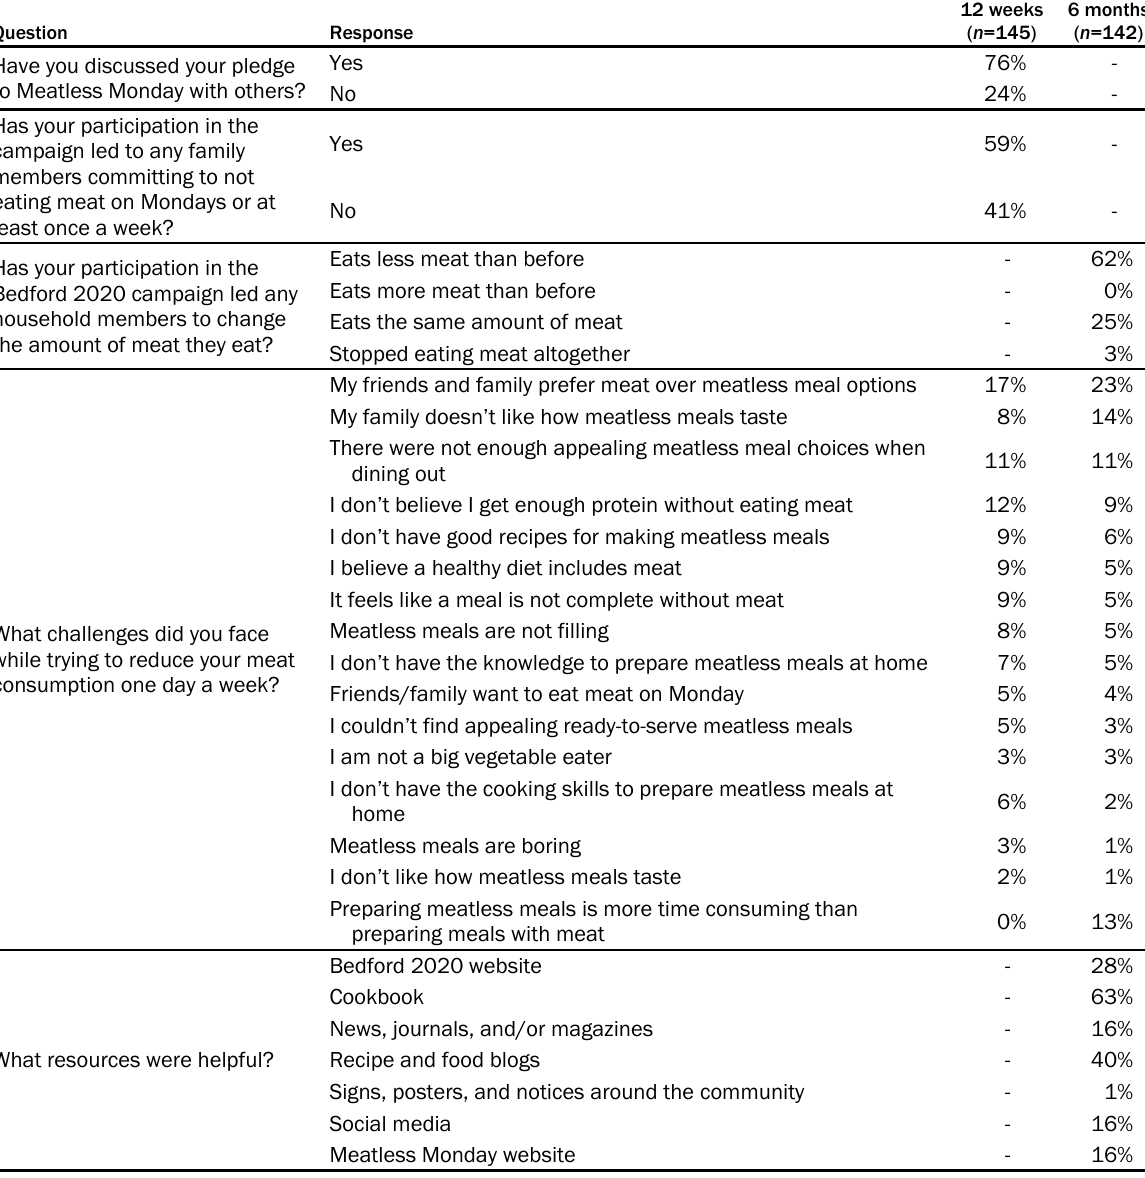
Table 5. Participants’ Discussion about the Campaign, Influence o n Others’ Meat Consumption, and Barriers to Behavior